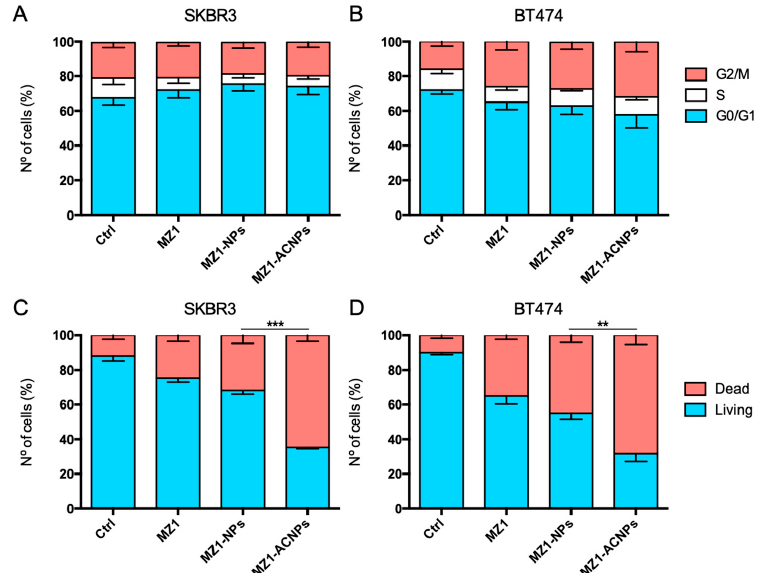
Figure 4. MZ1-encapsulated nanoparticles do not affect cell cycle distribution in HER2+ cell lines and increase cell death by apoptosis induction in HER2+ cell lines. Distribution of cells (in % of the total) under treatment with vehicle, free MZ1, MZ1-NPs, or MZ1-ACNPs in SKBR3 ( A , C ) and BT474 ( B , D ) HER2+ cell lines, evaluated by flow cytometry. ** p < 0.01; *** p < 0.001.